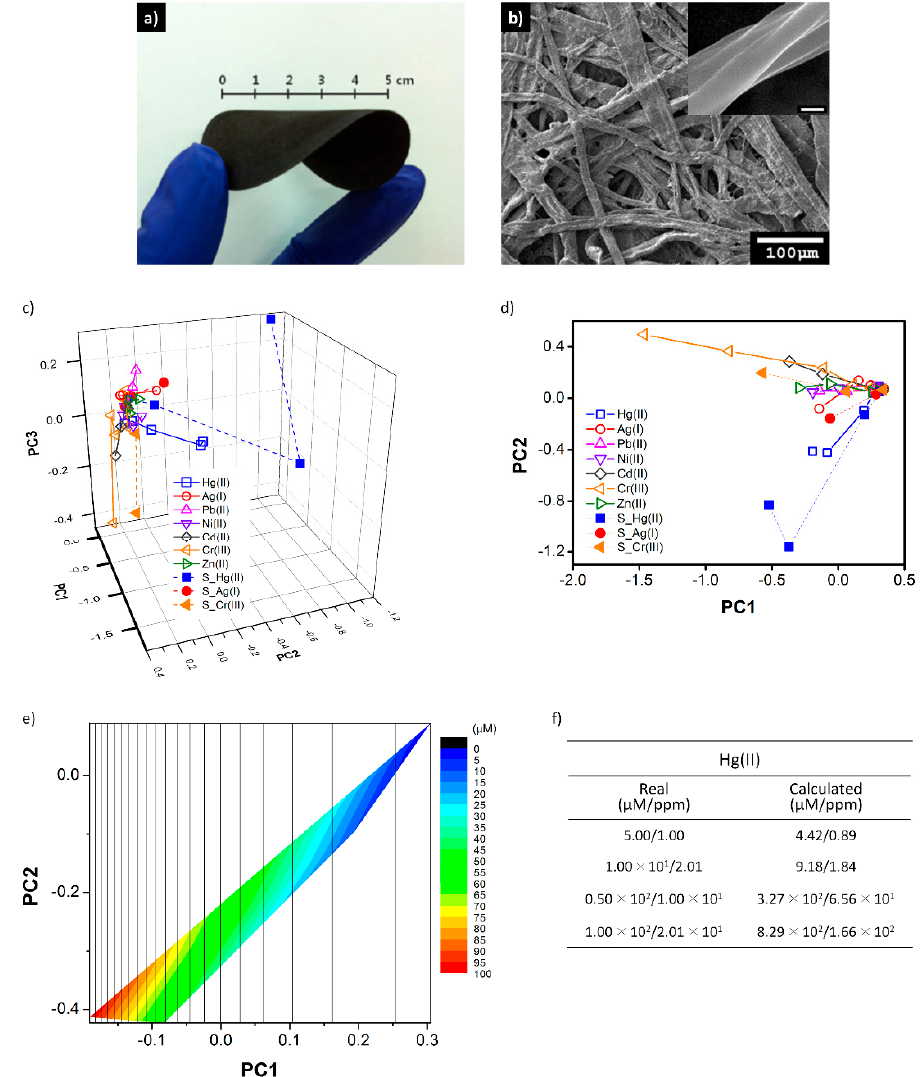
Figure 11. Photograph showing ( a ) the flexibility of a large-area, freestanding PPy/cellulose paper; ( b ) SEM images of a PPy/cellulose paper (inset: high-magnification image, the scale bar is 200 nm); ( c , d ) Principal component analysis plots of the responses of PPy/cellulose papers with data from real samples; ( e , f ) Calculation of Hg(II) concentration in groundwater. Reprinted with permission from [187]. Copyright 2014, Royal Society of Chemistry.